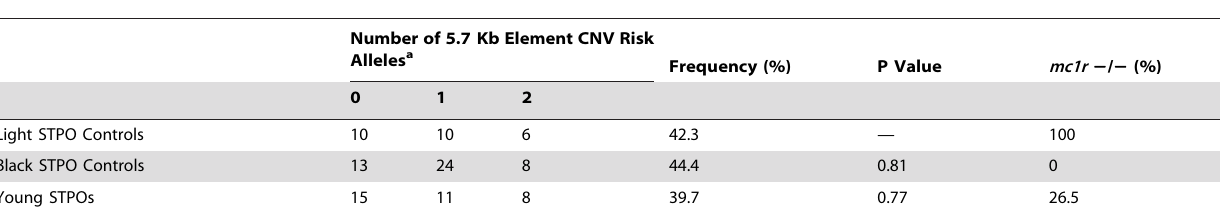
Table 4. Frequency of the 5.7-Kb element CNV in light colored, black, and young STPOs.